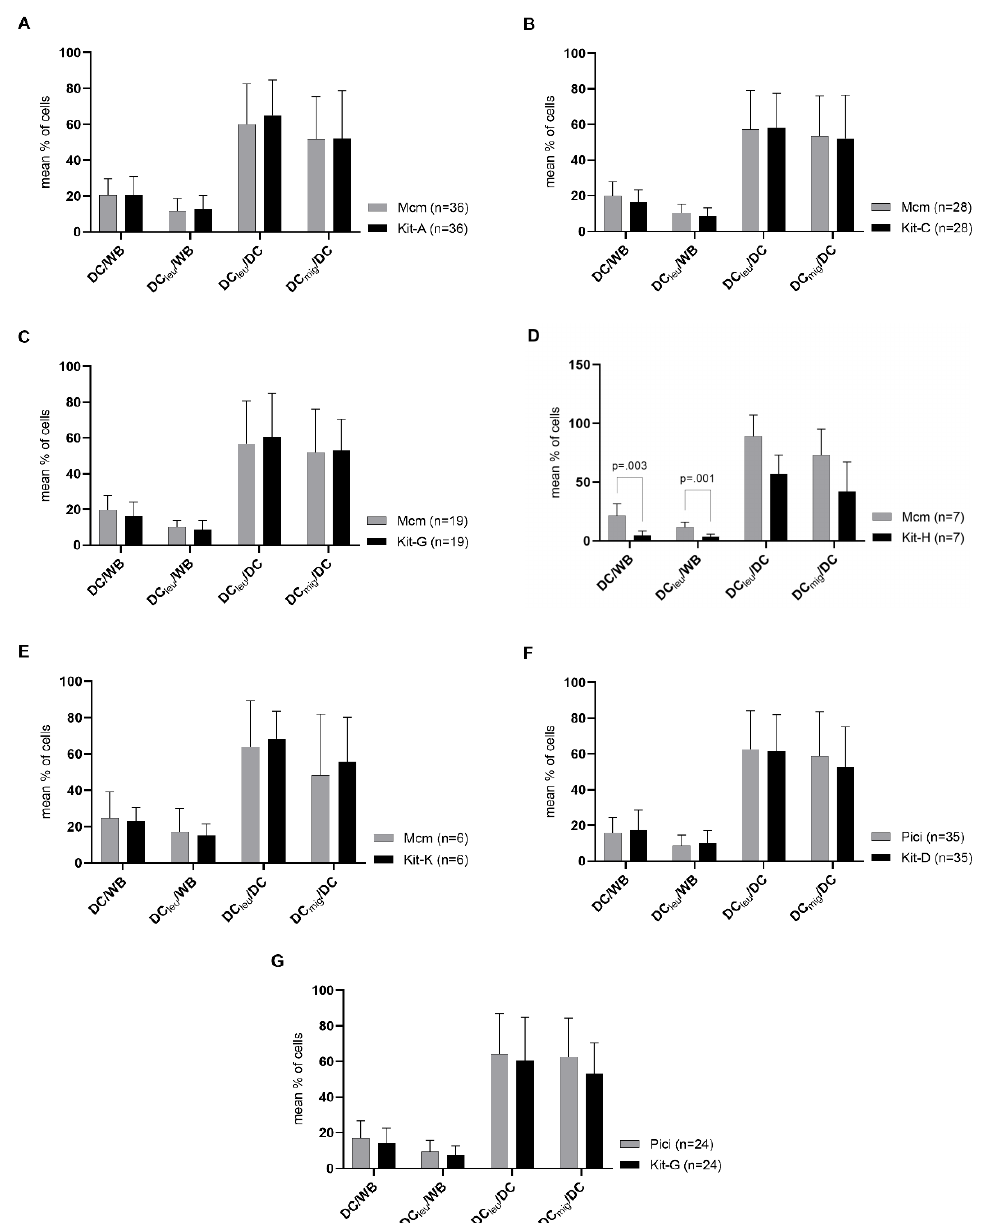
significant differences ( p values < 0.05) (two-tailed t-test) are given.